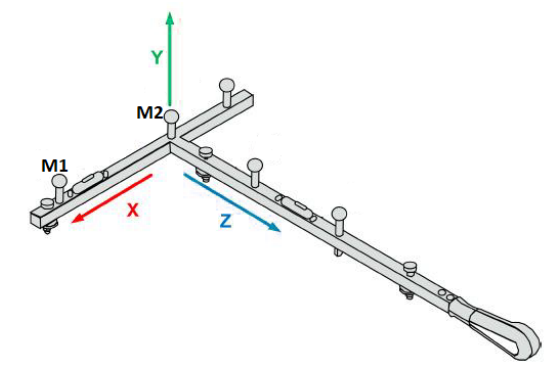
Figure 5. Vicon calibration wand schema